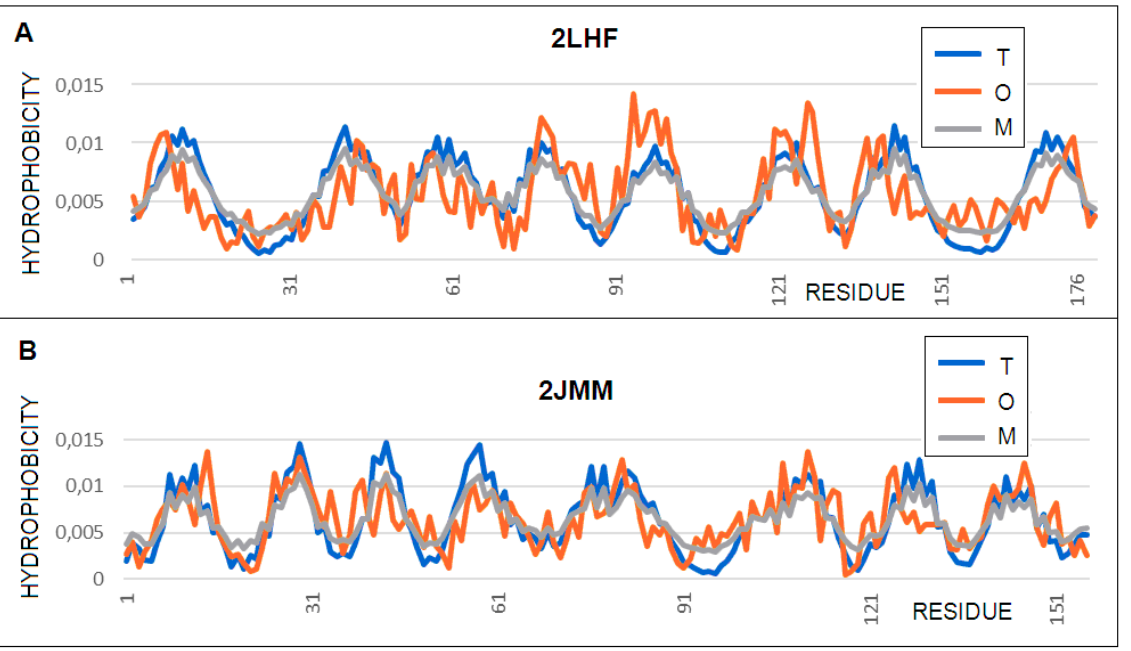
Figure 2. Profiles T (blue), O (red), and M (gray) for: ( A )—2LHF, with the profile M for K = 0.2 and ( B) —2JMM, with the profile M for K = 0.3.